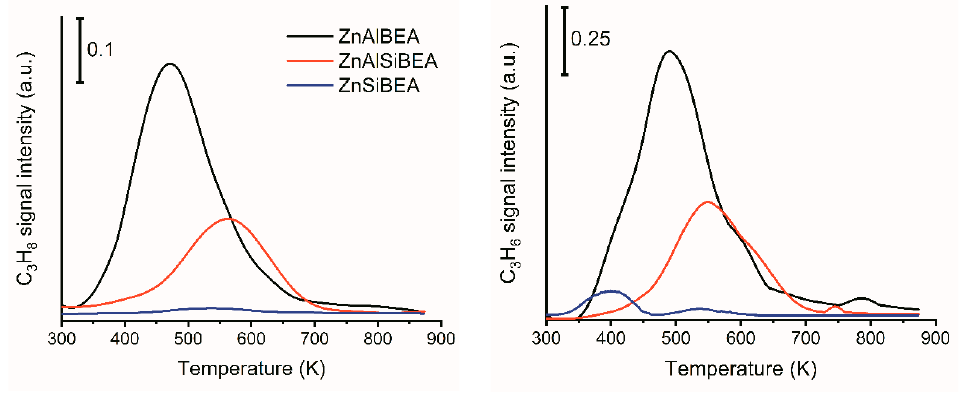
Figure 8. Normalized TPD pro fi les of propane and propene for the Zn-BEA catalysts.